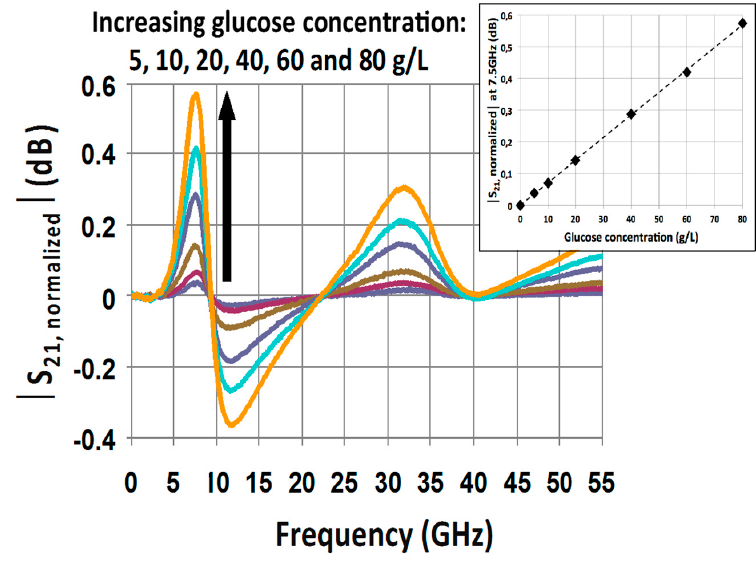
Figure 5. Measured normalized spectra S21 for the highest eight concentrated glucose solutions in the same frequency range.